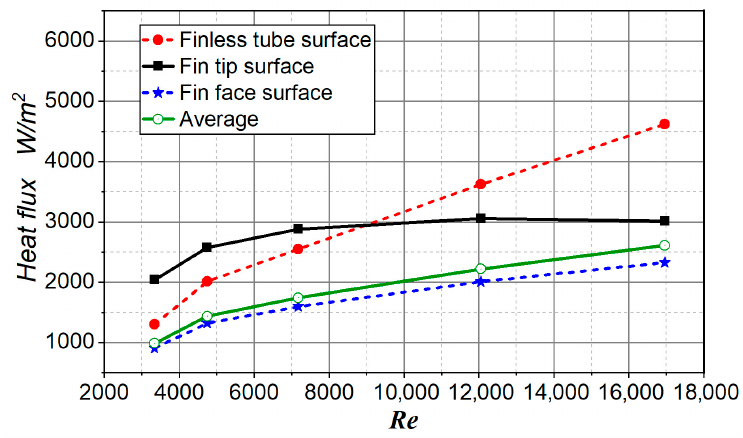
Figure 13. Heat flux on annular fin surfaces.